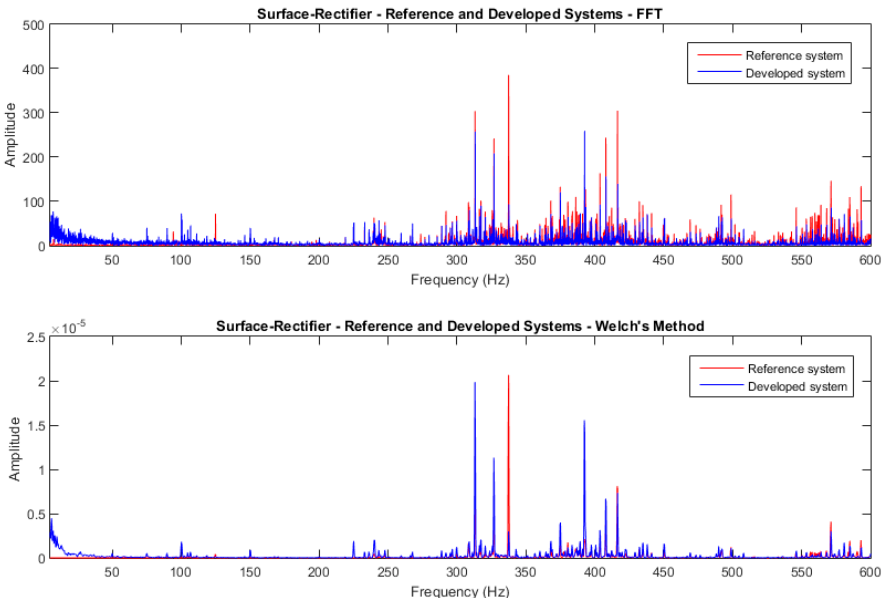
Figure 13. Comparison of vibration signatures obtained from the measurements performed on a surface-rectifier machine. The top plot shows the results obtained by applying the FFT. The bottom plot shows the results obtained by applying Welch’s method.